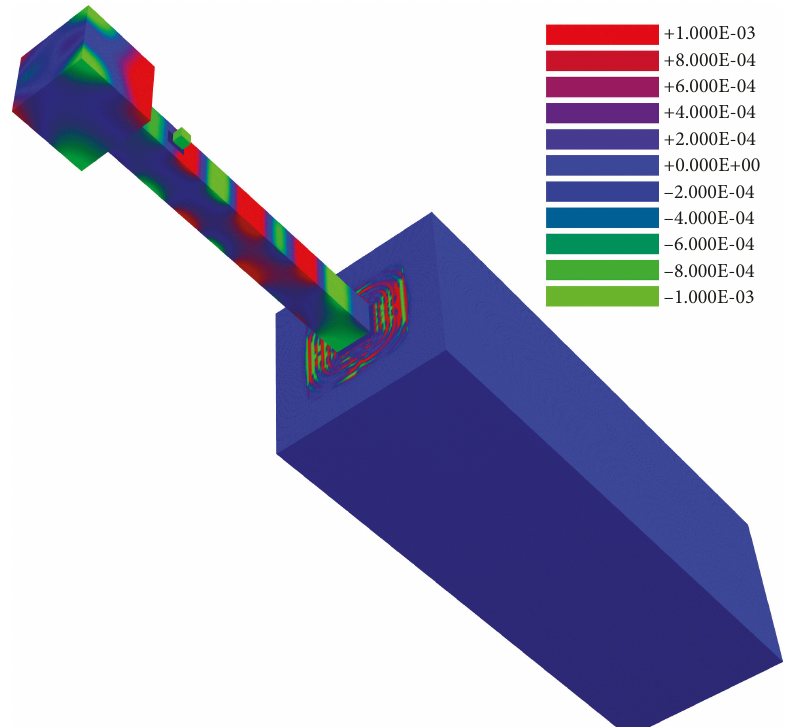
Figure 26: 3D contours of the impact on the concrete block (time t